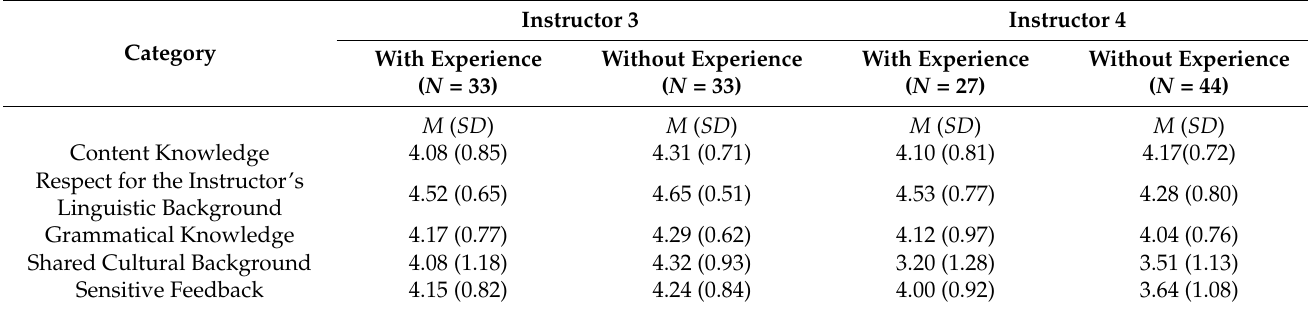
Table 6. Instructor profile ratings based on previous experience with that instructor